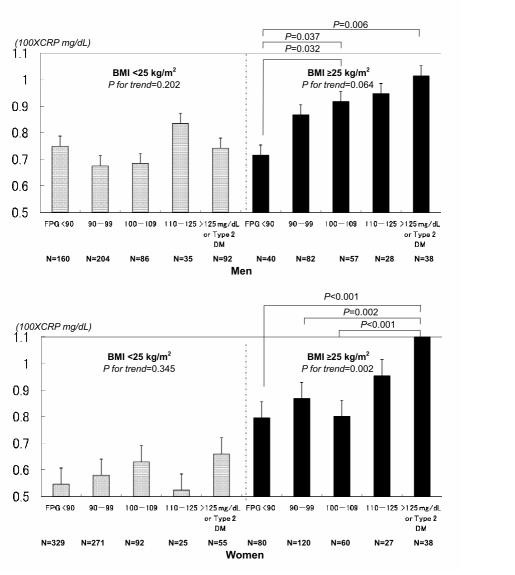
Geometric mean levels of high sensitivity C-reactive protein (hsCRP) and standard error bars, according to obesity, and fasting plasma glucose (FPG) category. Obesity was defined as a body mass index of ≥25 kg/m2. hsCRP levels were adjusted for age, smoking status, systolic blood pressure, high-density lipoprotein cholesterol, uric acid, and high molecular weight (HMW) adiponectin. Data for HMW adiponectin and hsCRP were skewed, and log-transformed for analysis.